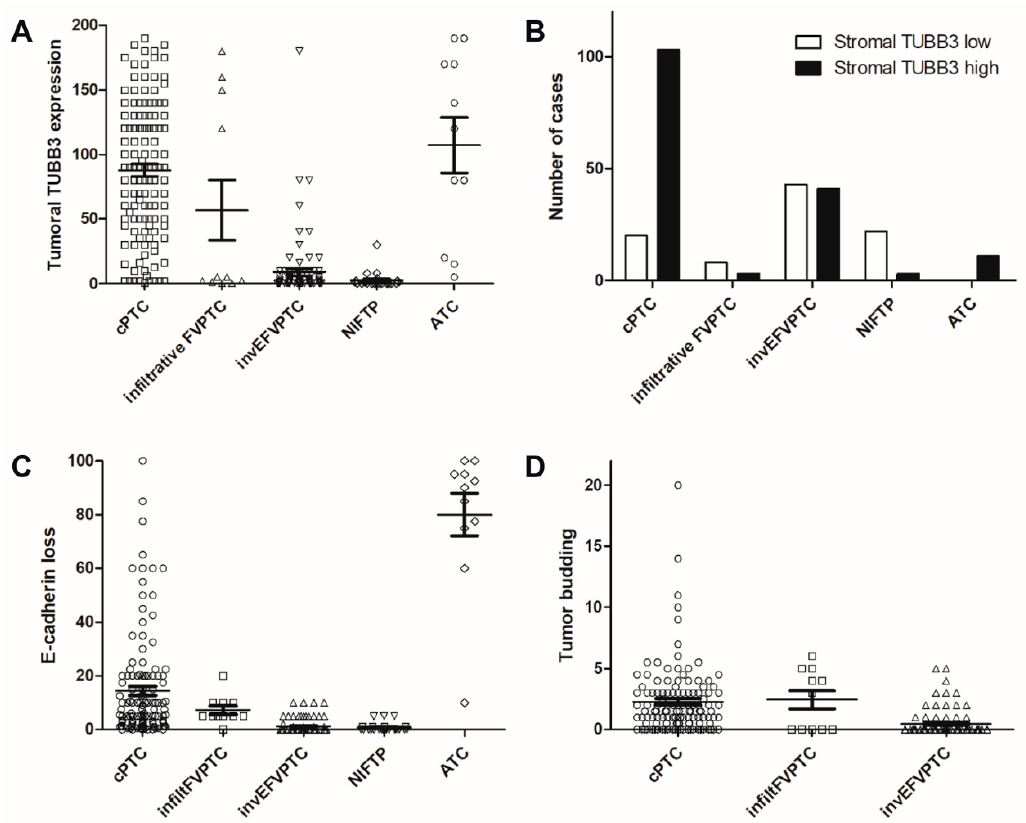
Figure 2. Differences of TUBB3 and E-cadherin expression and tumor budding among thyroid cancers. ( A ) TUBB3 H-score was highest in ATC, followed by cPTC, infiltrative FVPTC, invEFVPTC, and NIFTP. ( B ) High stromal TUBB3 expression was more common in cPTC and ATC than in invEFVPTC and NIFTP. ( C ) The proportion of tumor cells showing loss of E-cadherin expression, which was also highest in ATC, followed by cPTC, infiltrative FVPTC, invEFVPTC, and NIFTP. ( D ) Tumor budding was more commonly observed in cPTC and infiltrative FVPTC than in EFVPTC. cPTC; conventional papillary